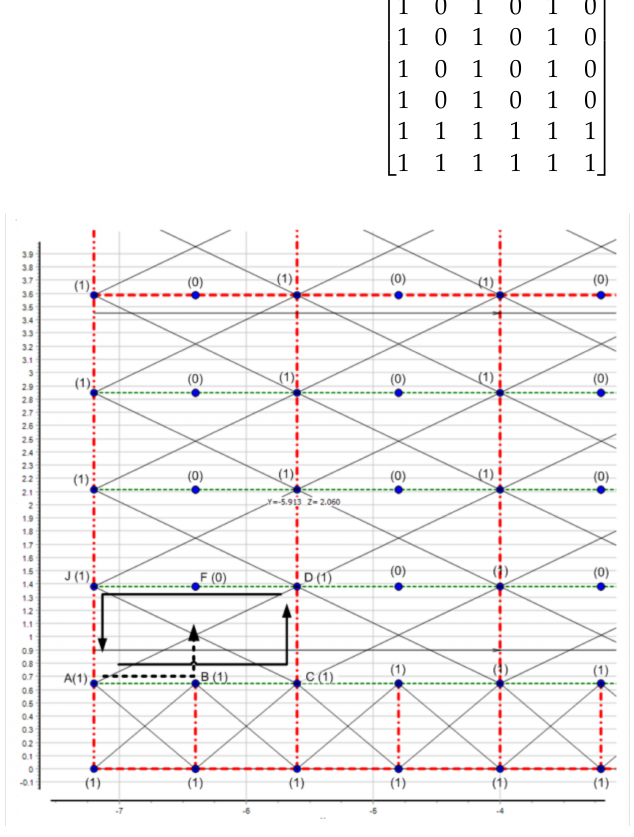
Figure 6. Searching for the panel borders (A-C-D-J points) on the expansion of shell plating in the area of a ship’s parallel middle body. The primary supporting members and adjacent structures are shown in red, the stiffeners are shown in